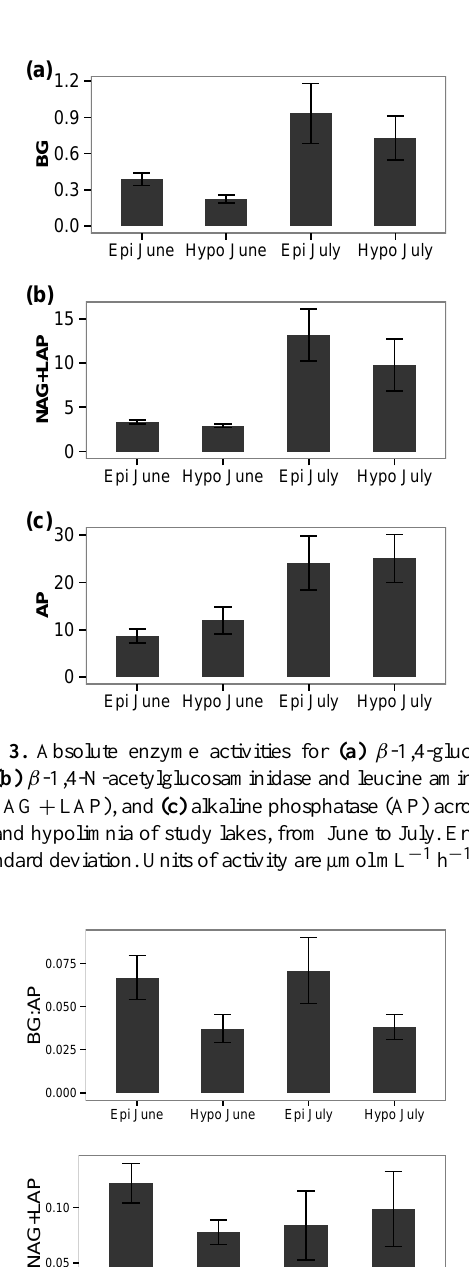
Figure 6. Response of (a) AP, (b) BG, and (c) BG : AP to DOC in lake epilimnia. Data from June are indicated by gray triangles; data from July are indicated by black circles. Only significant relation- ships are